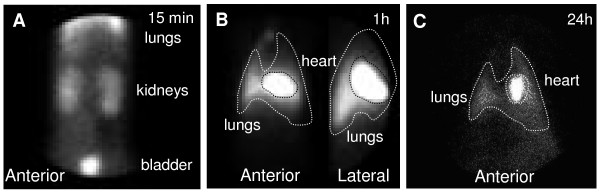
99mTc-BM-MNC biodistribution in animals with myocardial infarction after intracoronary injection. A-B: abdomen (A) and thorax (B: anterior and lateral) scintigraphic images at 15 minutes and 1 hour. C: thorax scintigraphic image at 24 hours in the same animal.